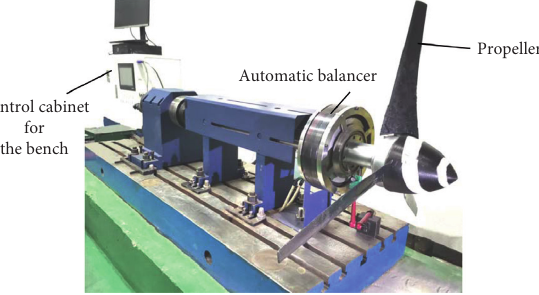
Figure 8: Propeller simulation automatic balance test bench. Table 1: Experimental data of the pulse-counting method. Seri.